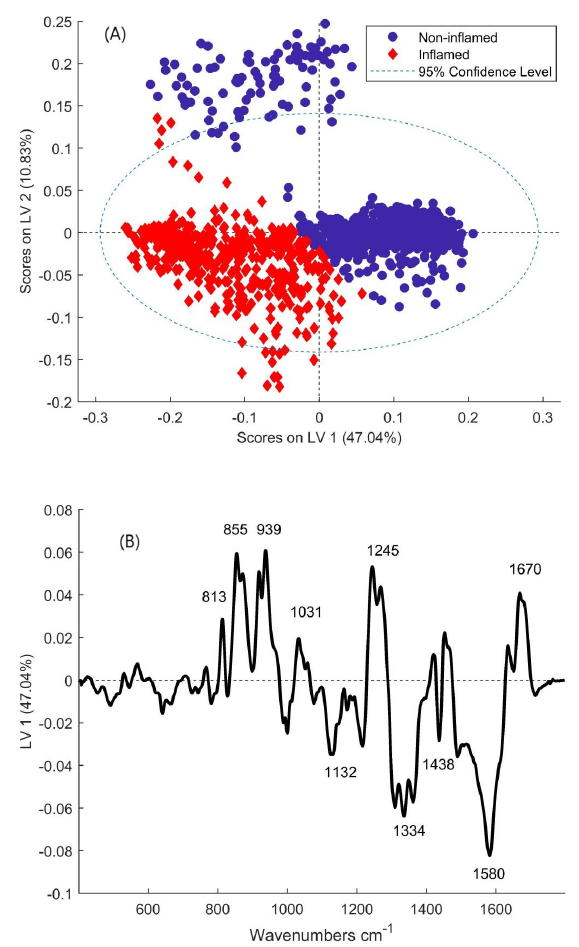
Figure 4. ( A ) Scores of inflamed and non-inflamed moderately dysplastic connective tissue on the latent variables from the PLSDA model. ( B ) Loading of LV-1 from the PLSDA model of inflamed vs non-inflamed connective